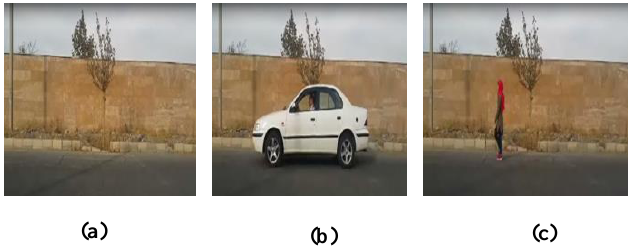
Figure 2. (a) A model of the estimated background using Gaussian mixture models. (b) a frame which consists of a car (c) a